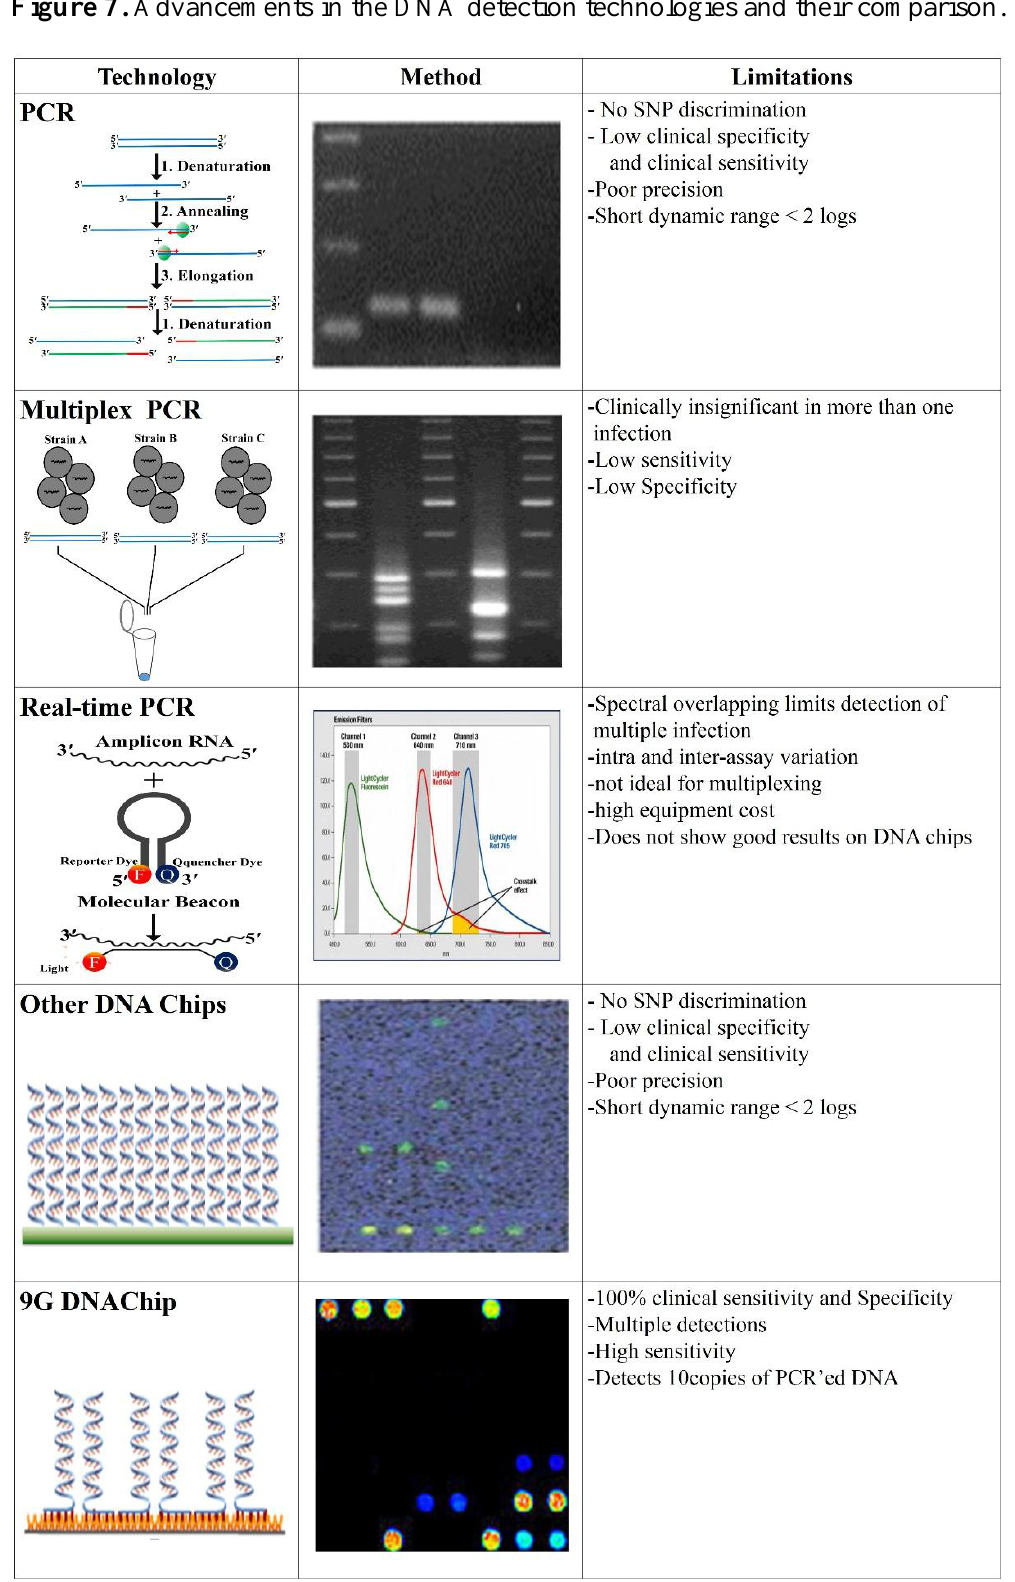
Figure 7. Advancements in the DNA detection technologies and their